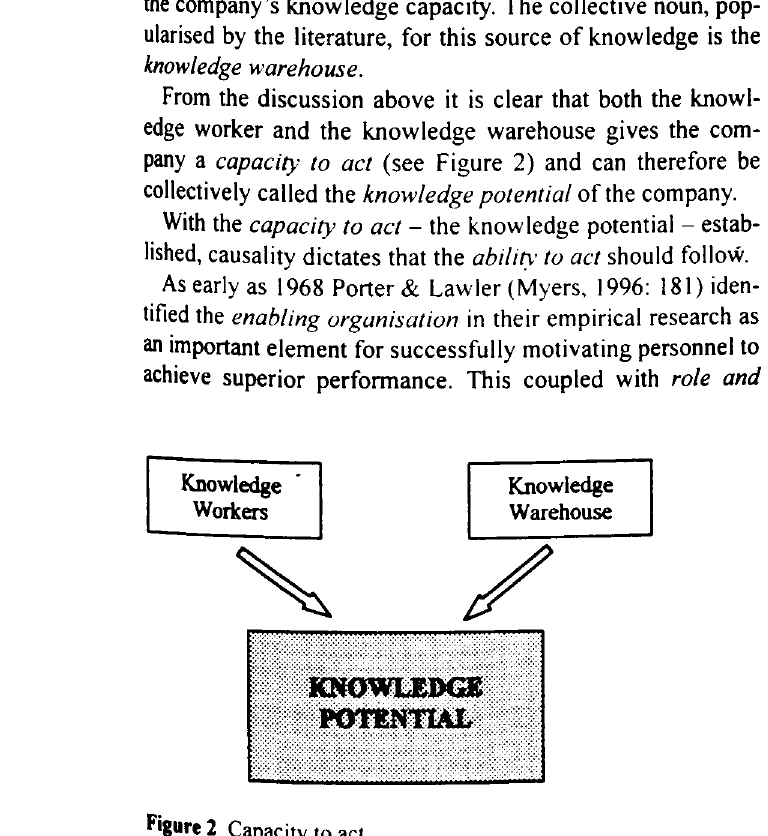
Figure 2 Capacity to act